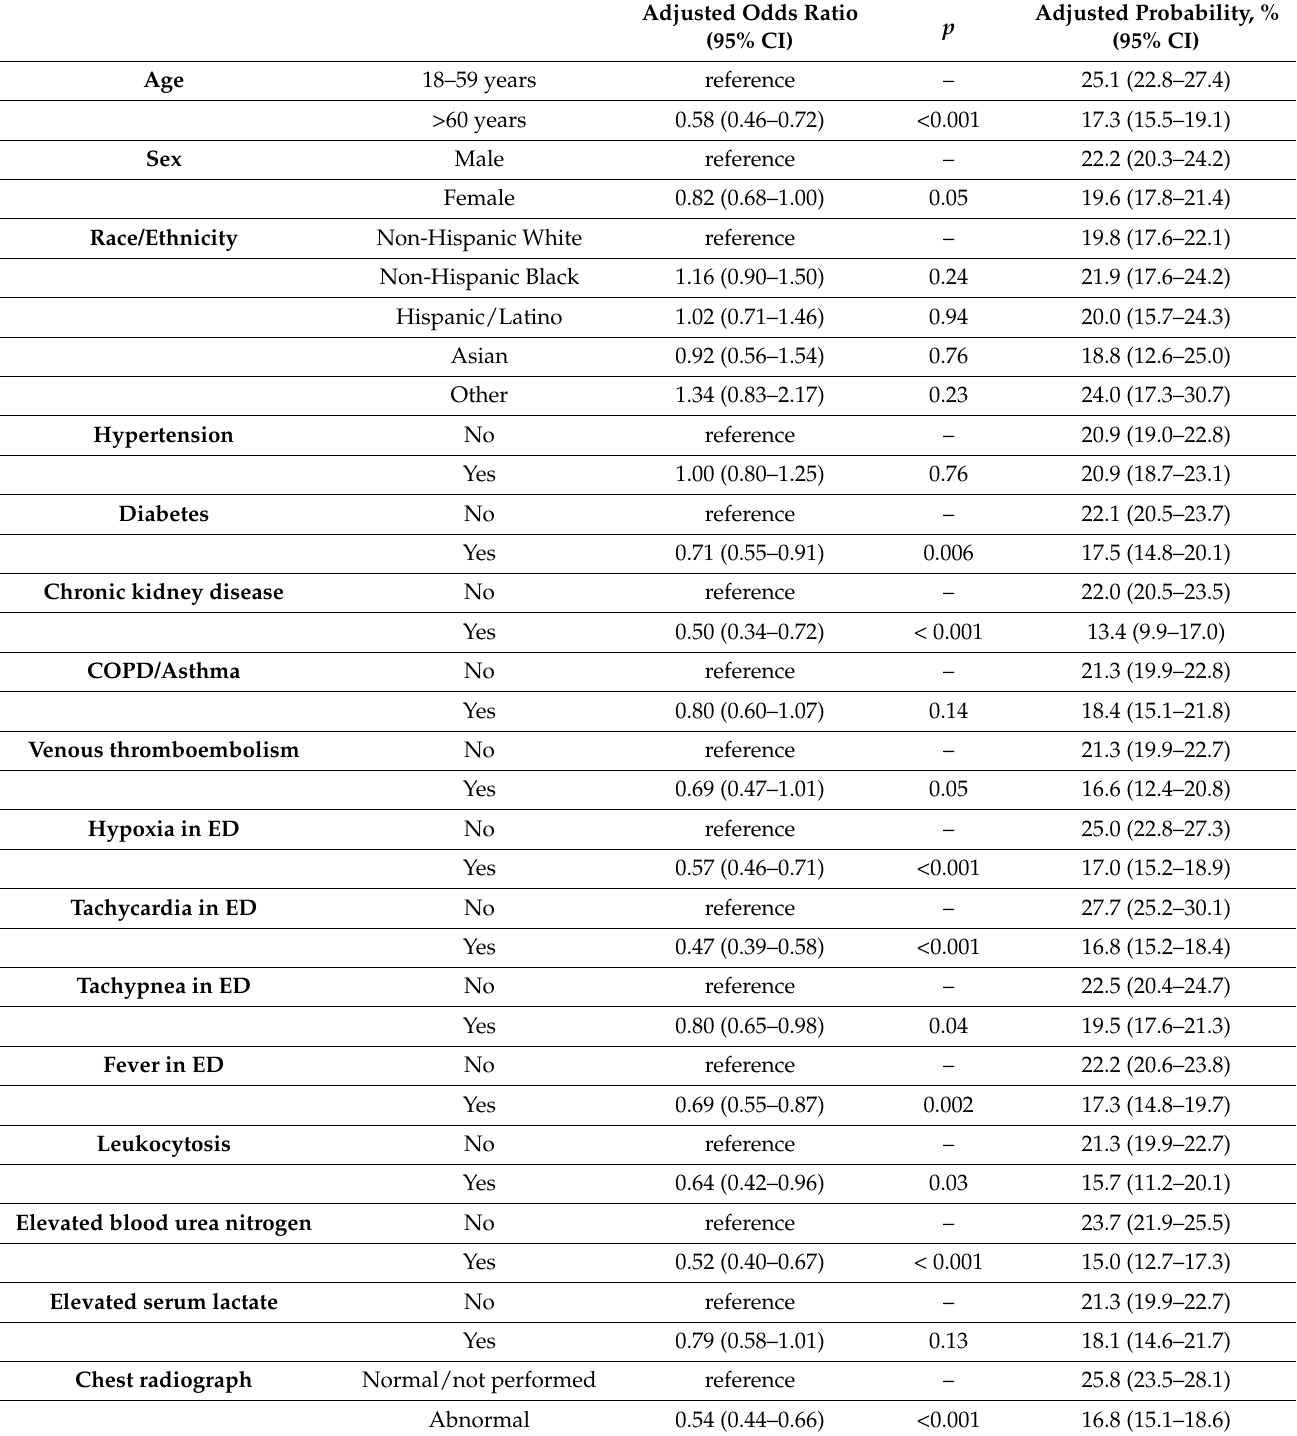
Table 2. Adjusted odds ratios and adjusted probability of short-stay hospitalization for COVID-19 for patient